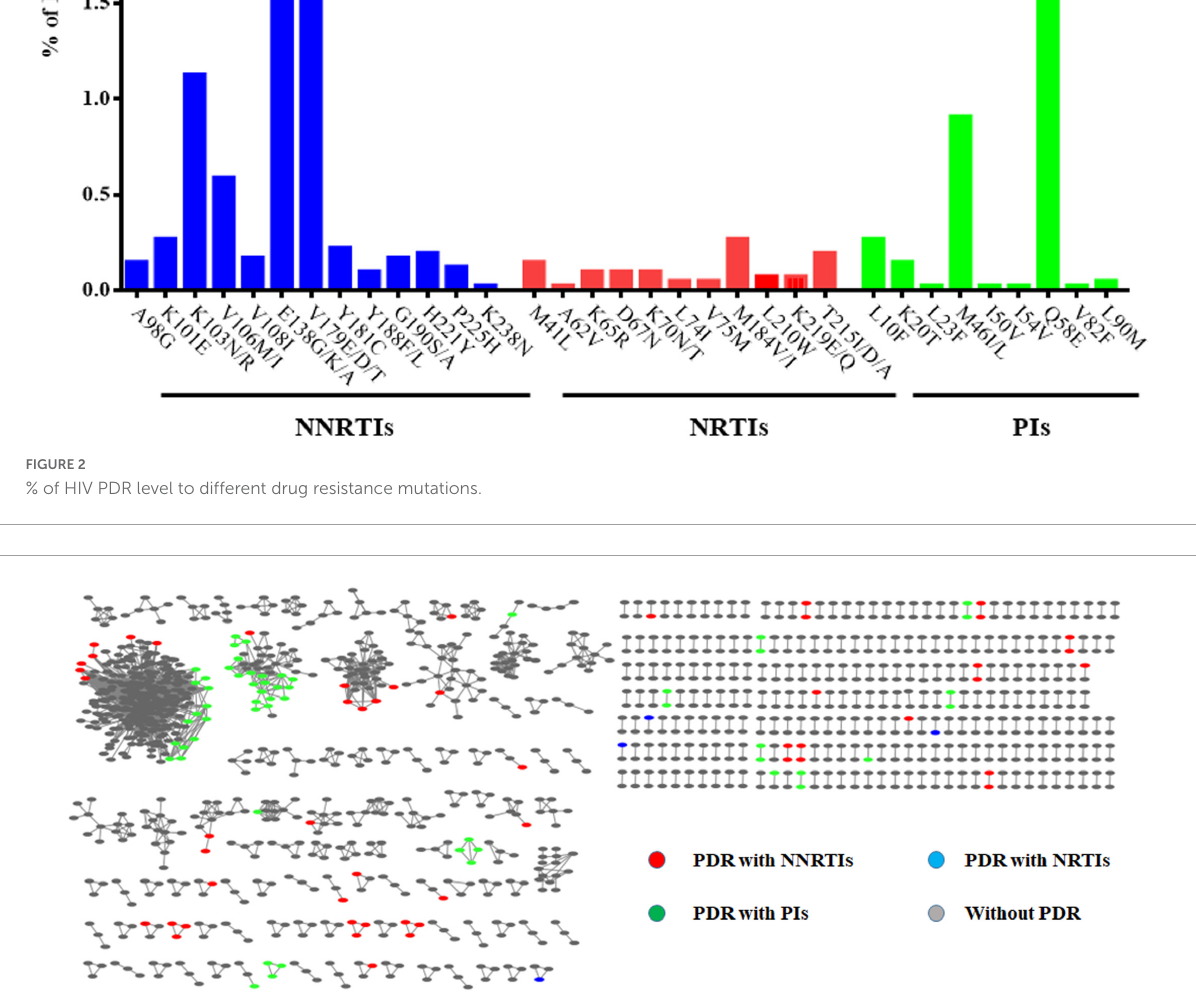
Resistance Surveillance Report, the PDR of NNRTIs in 12 of the 18 monitored regions exceeded 10% (11). Interestingly, the prevalence of PDR to PIs was as high as 3.0% in our